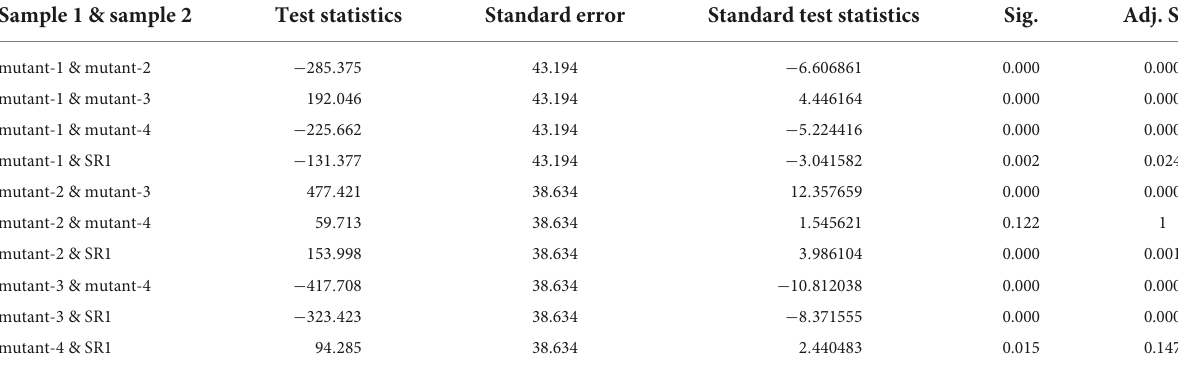
TABLE 1 The independent samples Kruskal–Wallis test of green fluorescence